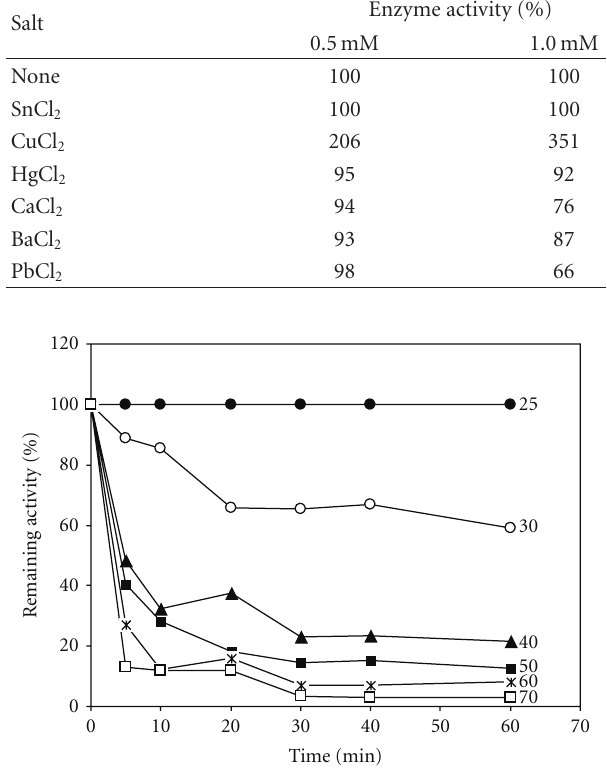
Figure 3: E ff ect of heat treatment on rainbow trout rhodanese activity as a function of treatment time at di ff erent temperatures. The remaining activity was expressed as a percentage of activity of the enzyme incubated at 25 ◦